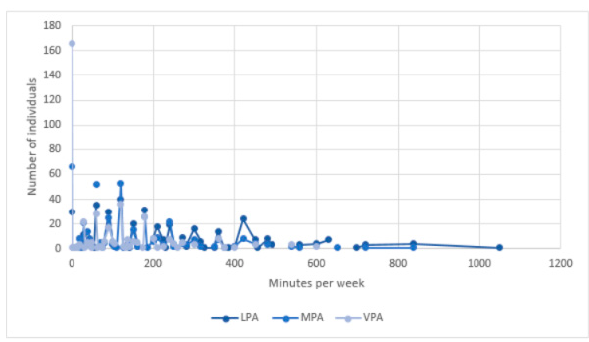
Figure 1. Frequency per week (per physical intensity level.